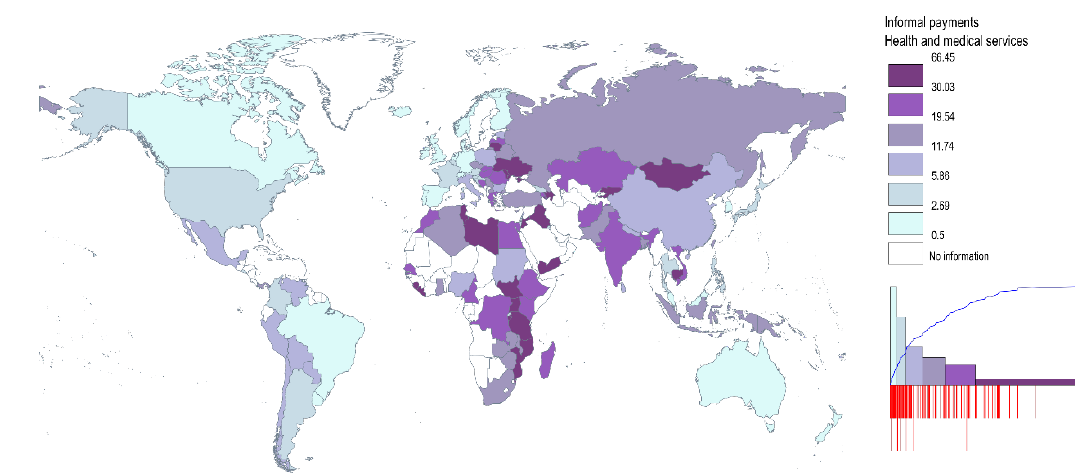
Figure 1. The incidence of under-the-table payments in health (% respondents, 2009 – 2013). Notes: This is based on their